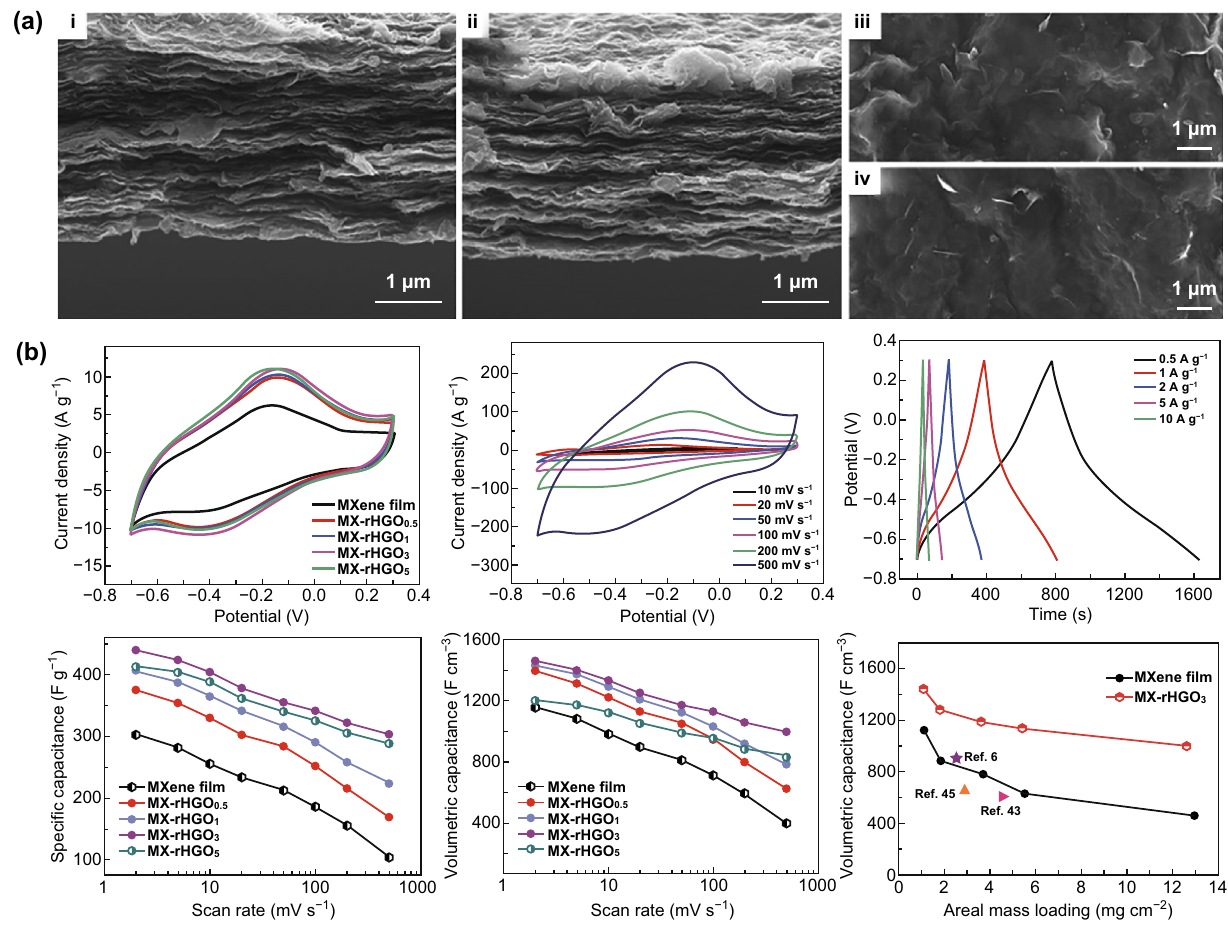
Fig. 8 Ti 3 C 2 T x -rHGO nanoporous network. a Cross section (i, ii) and SEM images (iii, iv) of Ti 3 C 2 T x film (i, iii) and Ti 3 C 2 T x -rHGO films (ii, iv). b CV and GCD curves of Ti 3 C 2 T x films and Ti 3 C 2 T x -rHGO and effects of areal mass loading on the volumetric capacitance. MX-rHGO x , where x is the percentage of the weight of holey graphene oxide in the mixture. Reproduced with permission from Ref.